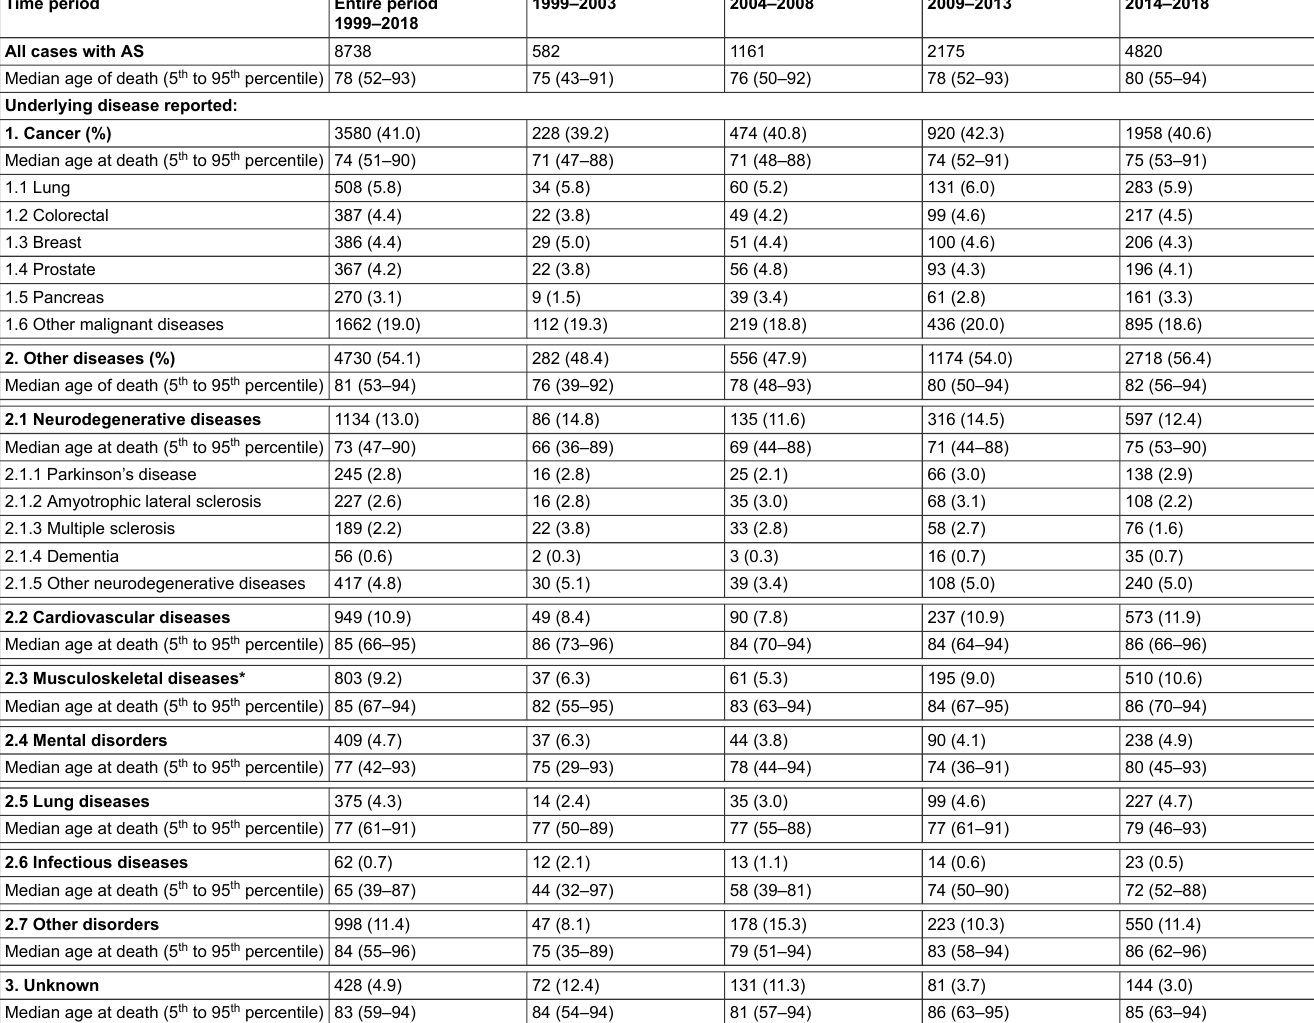
Table 3: Assisted suicide (AS) cases in Switzerland (1999–2018): distribution of underlying diseases.